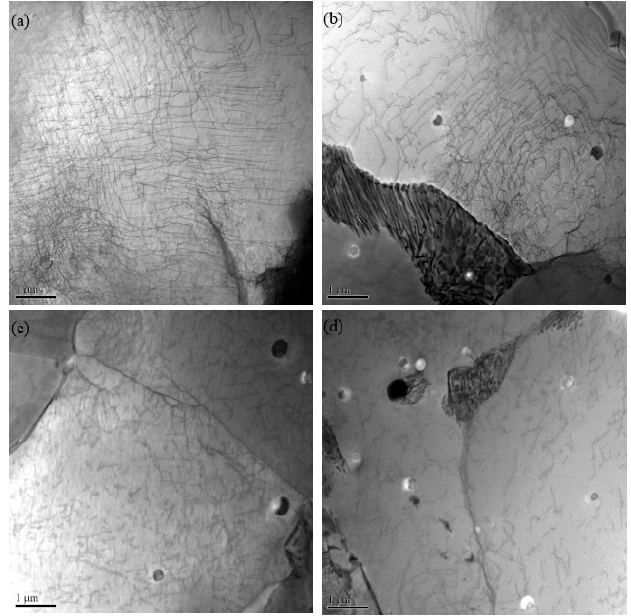
Figure 16. TEM morphology of the welding area after additive manufacturing and after EST. ( a , b ) After additive manufacturing; ( c , d )After EST.